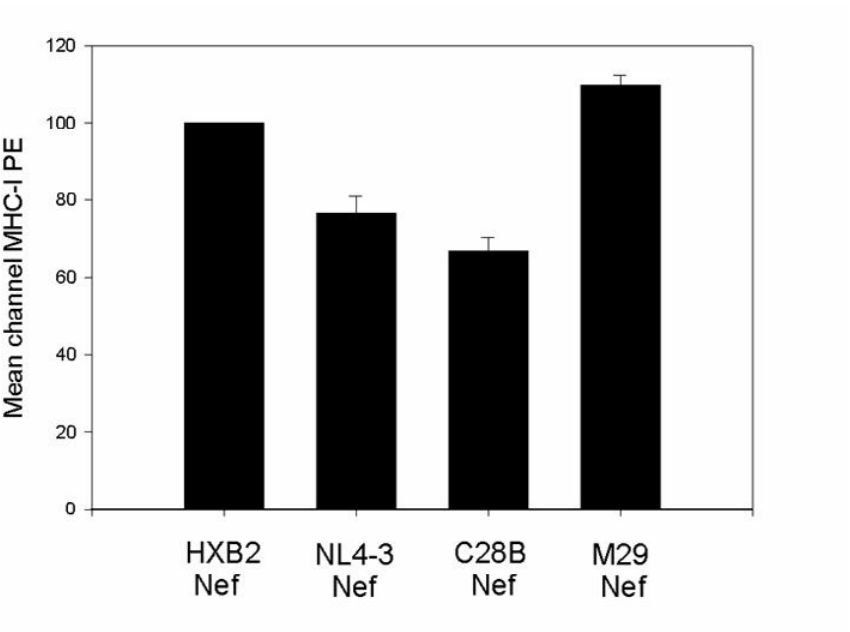
Figure 4. MHC class I down-regulation by patient Nefs. Mean channel fluorescence for MHC-I was measured in three separate experiments. MHC-I expression in the presence of HIV-1 at 100 %. Error bars indicate the standard error in three separate